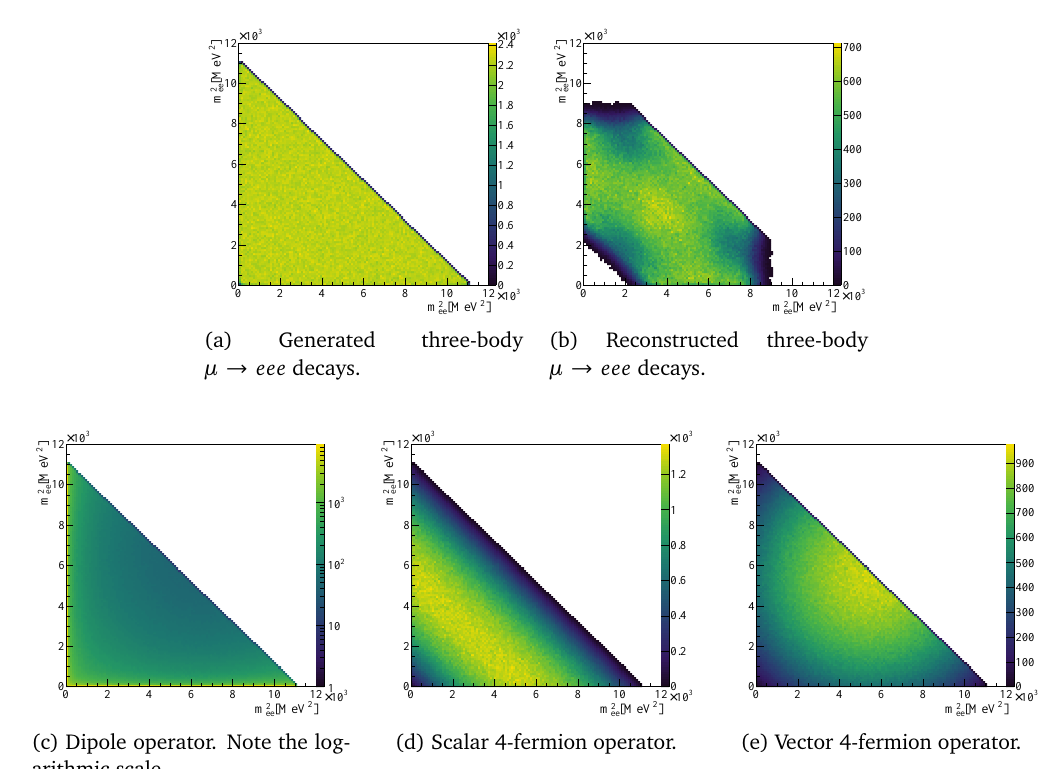
Figure 6: Dalitz plots of e + e − pairs in simulated µ → eee decays. In the effective theory approach, the operators are evaluated